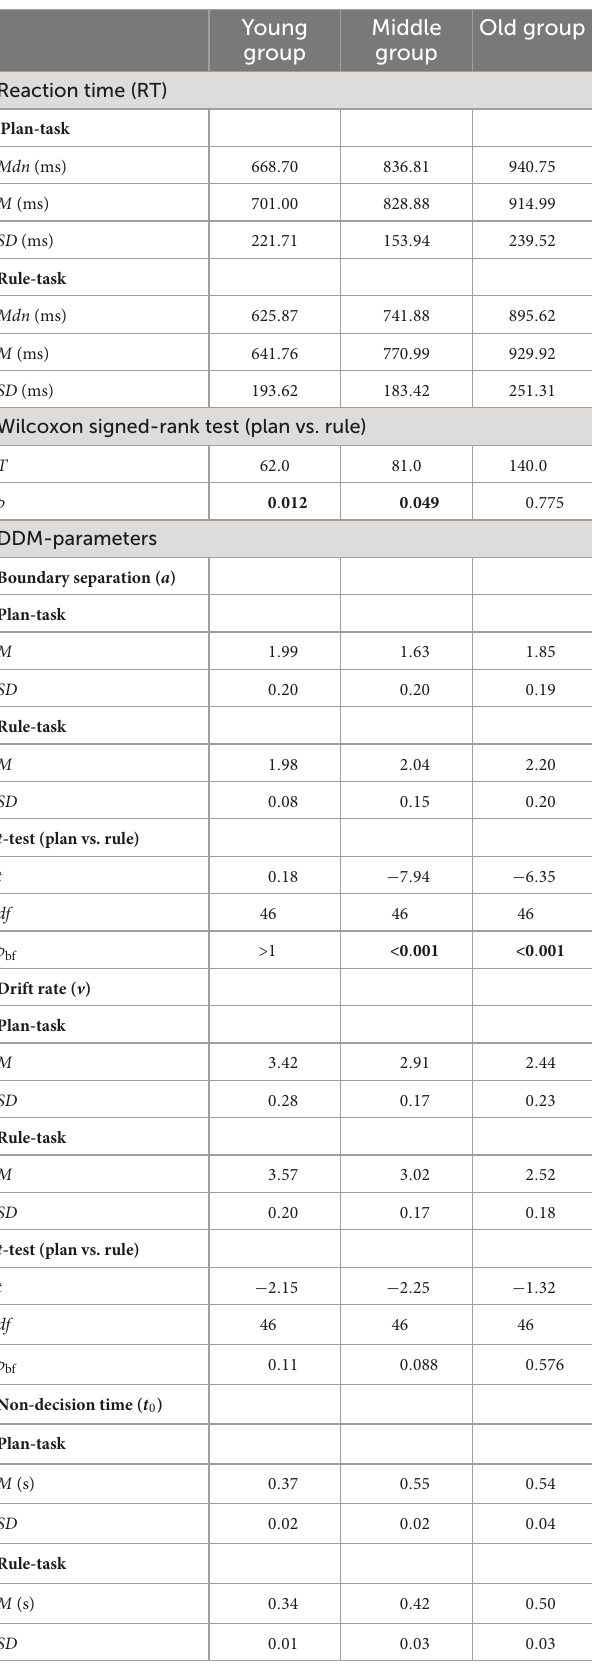
TABLE 1 Group statistics for reaction times (RTs) and drift diffusion model (DDM)